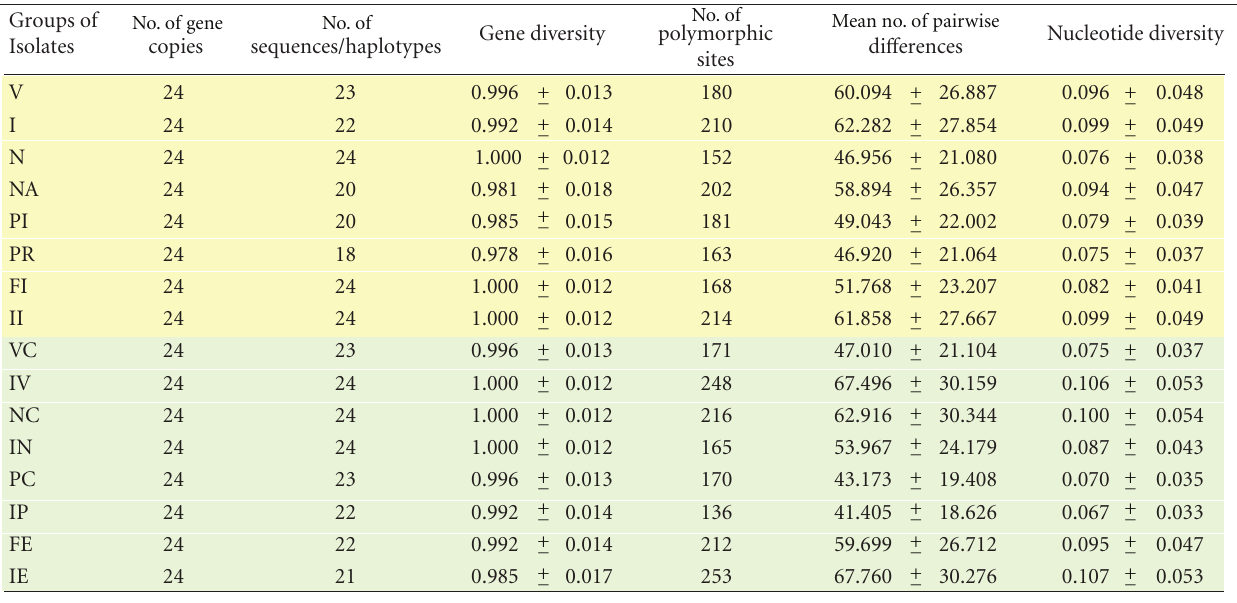
Table 3: Diversity indexes calculated for 16 populations of G. citricarpa from four orange varieties and two di ff erent geographic origins. Groups of Isolates